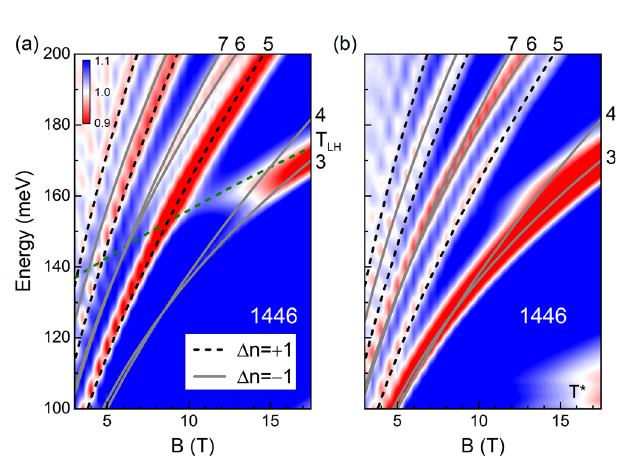
Fig. 3 | Circular polarization resolved magneto-IR absorption spectra. False color map of magneto-absorption at different energies for sample 1446 under the excitation of σ + ( a ) and σ − ( b ) circularly polarized light. The dash lines are the calculated LL transitions that follow the selection rule Δ n =+1, while the solid lines represent the Δ n = − 1 transitions. The low-lying transitions are numbered in the samesequenceasinFig.2c,d. T LH denotesaweaktransitionfromLHtoHHLLs,and T * marksamagnetic fi eld-independentspectralfeaturethatwebelieveisnotrelated to the band structure under this study. All measurements are performed at